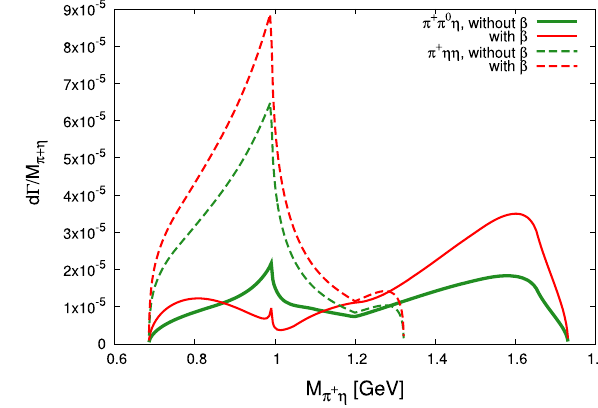
Fig. 13 Mass distributions with and without β term. The results with the β term correspond to Fig. 10(b)